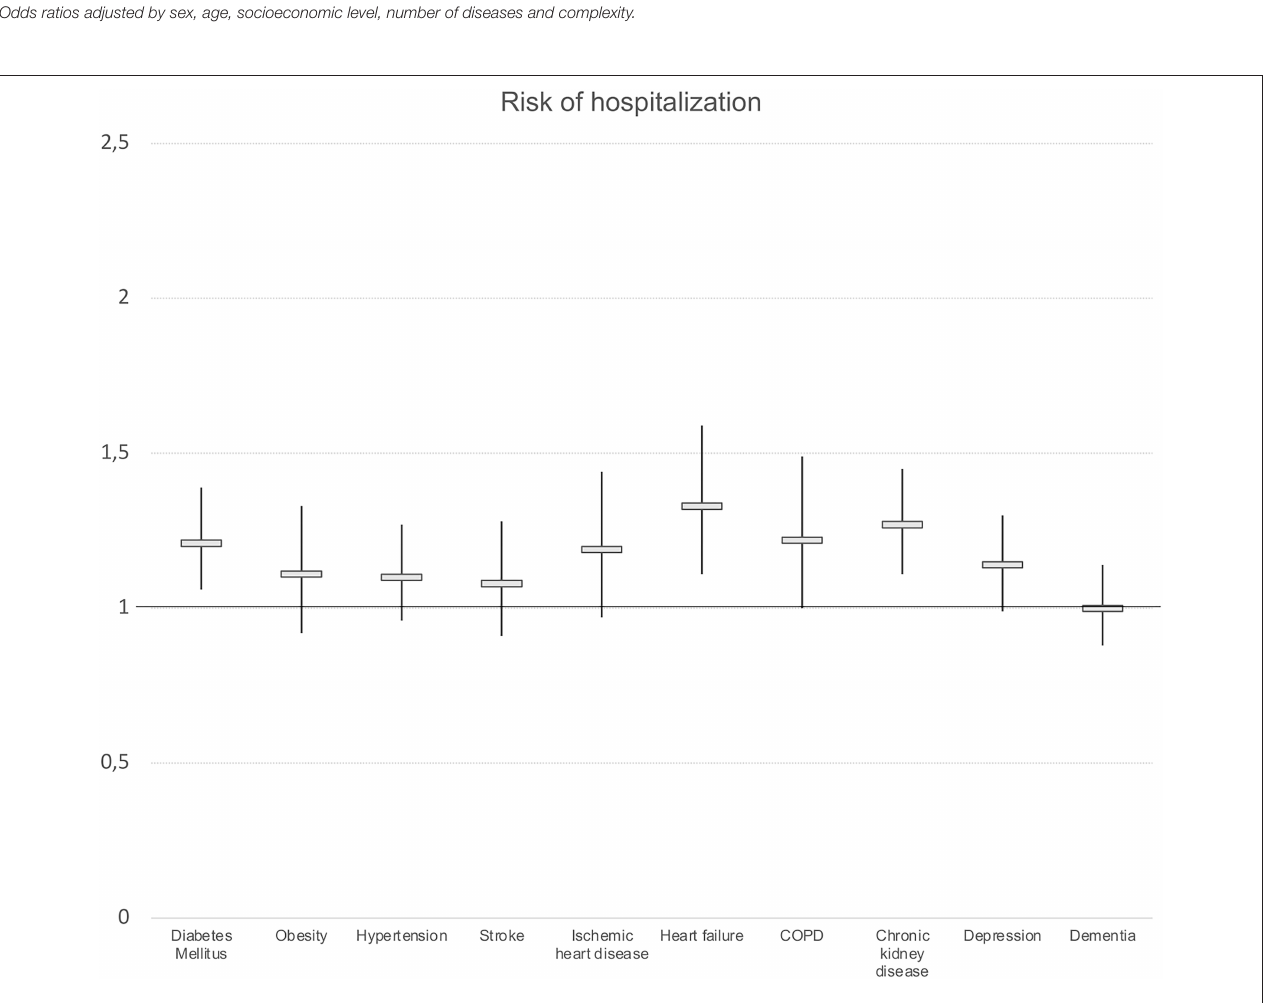
Frontiers in Public Health |